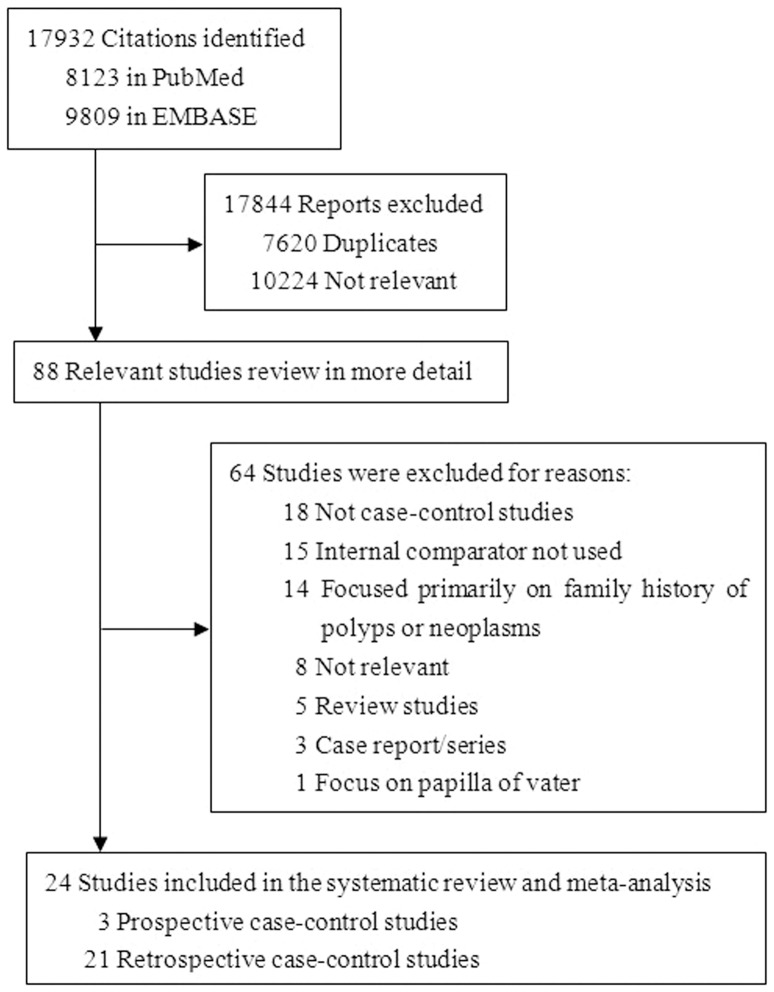
Study Selection Flow Chart.